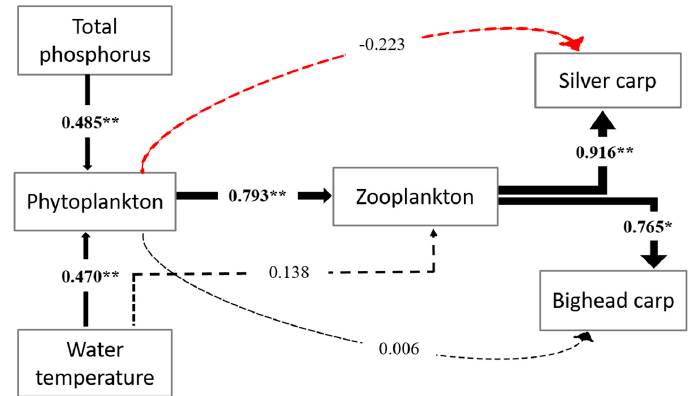
Figure 5. Path diagram of the SEM based on the interaction between environmental variables (total phosphorus, water temperature, density of phytoplankton and density of zooplankton) and trophic levels of the filter-feeding fish (bighead carp and silver carp). Boxes represent observed variables; directions of the arrows go from independent to dependent variables; numbers on the arrows correspond to the standardized path coe ffi cients, and the relative strength of a relationship is indicated by arrow thickness and the standardized path coefficient. Significant and non-significant path coe ffi cients are indicated by full and dotted lines, respectively; black and red arrows indicate positive and negative flows of causality ( p < 0.05), respectively. The model involves two independent variables (bighead carp and silver carp) and four dependent variables (total phosphorus, water temperature, density of phytoplankton, and density of zooplankton). Significant effects were denoted in bold, and asterisks indicate highly significant, with p < 0.01 (**) and significant, with 0.01 < p < 0.05 (*).